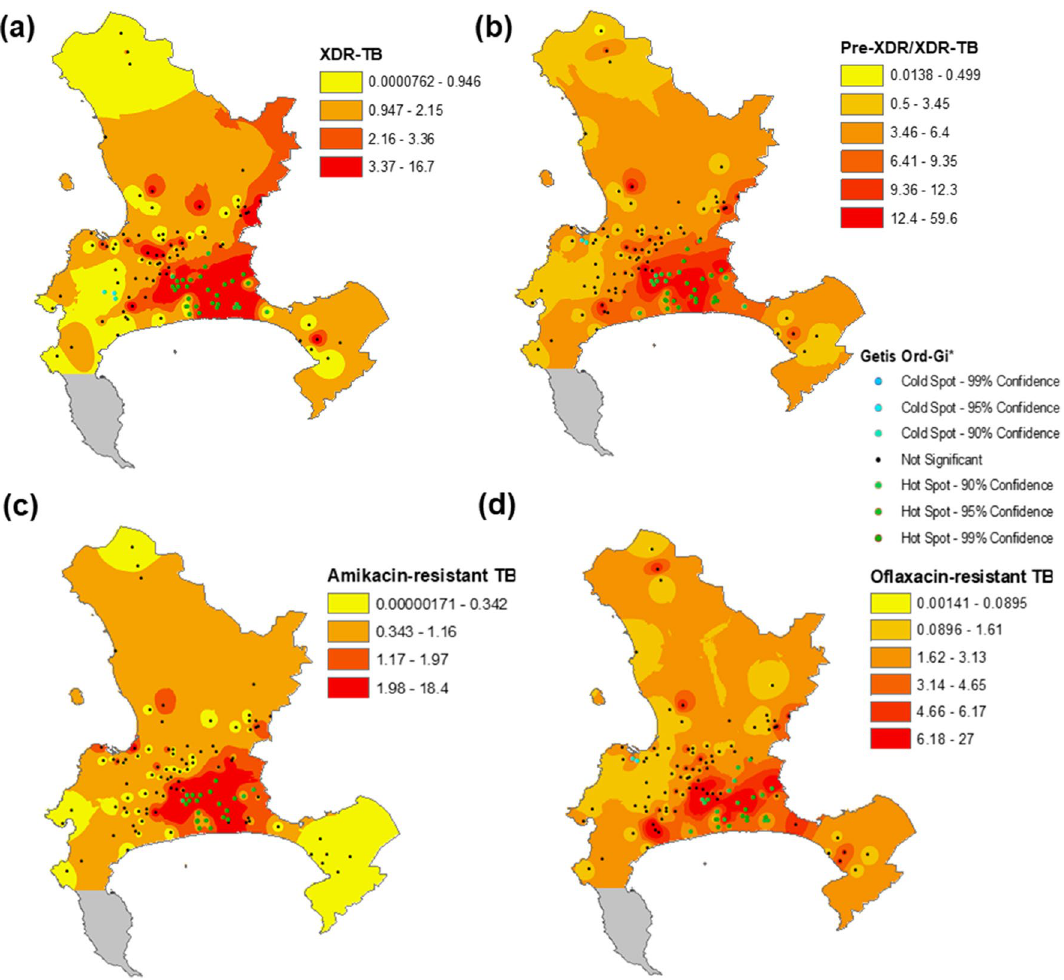
Figure 3. Inverse distance weighting map and Getis-Ord Gi* hotspot analysis of the counts of ( a ) XDR-TB, ( b ) pre-XDR/XDR-TB, ( c ) amikacin-resistant TB, and ( d ) ofloxacin-resistant TB in the city of Cape Town between 2012 and 2015. Figure created in ArcGIS version 10.8 24 . Colors are broken down by 1 standard deviation. Clinics are denoted as dots on the map, and each map is on a different scale. There are no clinics in Cape Point